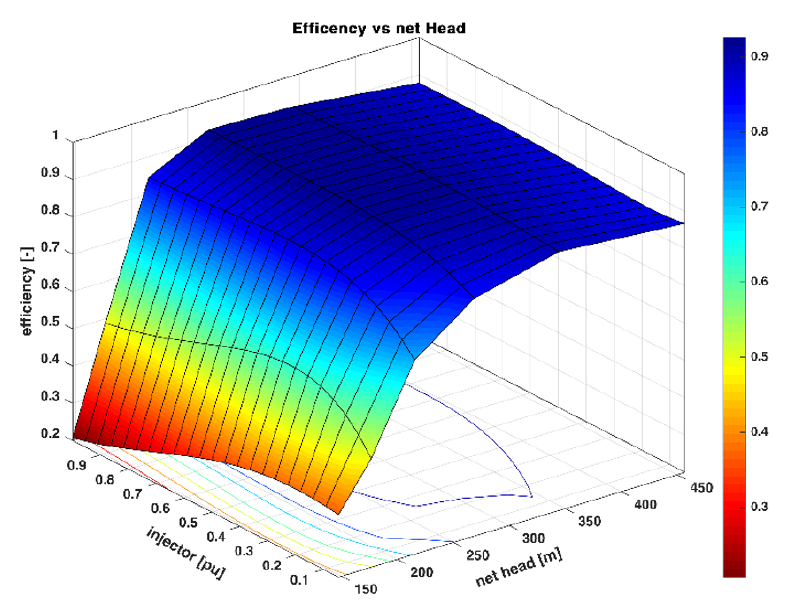
Figure 5. Estimation of the “falaise” occurrence based on the turbine characteristic used by the digital twin.